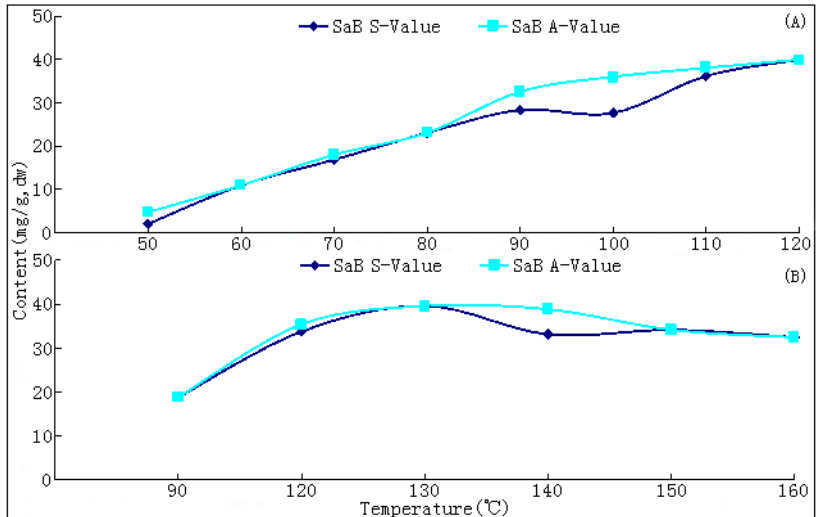
Figure 5. Contents of salvianolic acid B in sufficiently dried samples (S-values) and their apical values (A-values) at different drying temperature. ( A ) results of experiment 1; ( B ) results of experiment